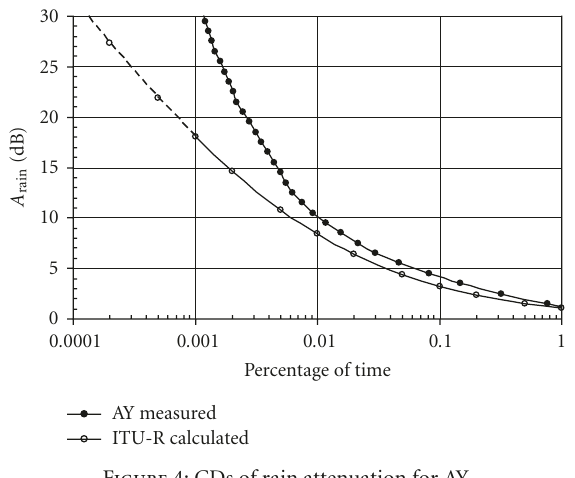
Figure 4: CDs of rain attenuation for AY.